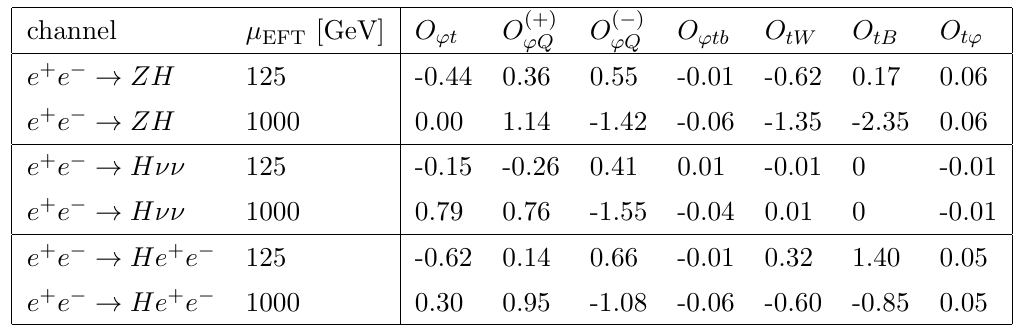
Table 4 . Percentage deviation (cid:22) ij for production channel i and operator j for 250 GeV and P ( e + ; e (cid:0) ) = ( 30% ; 80%). (cid:0)